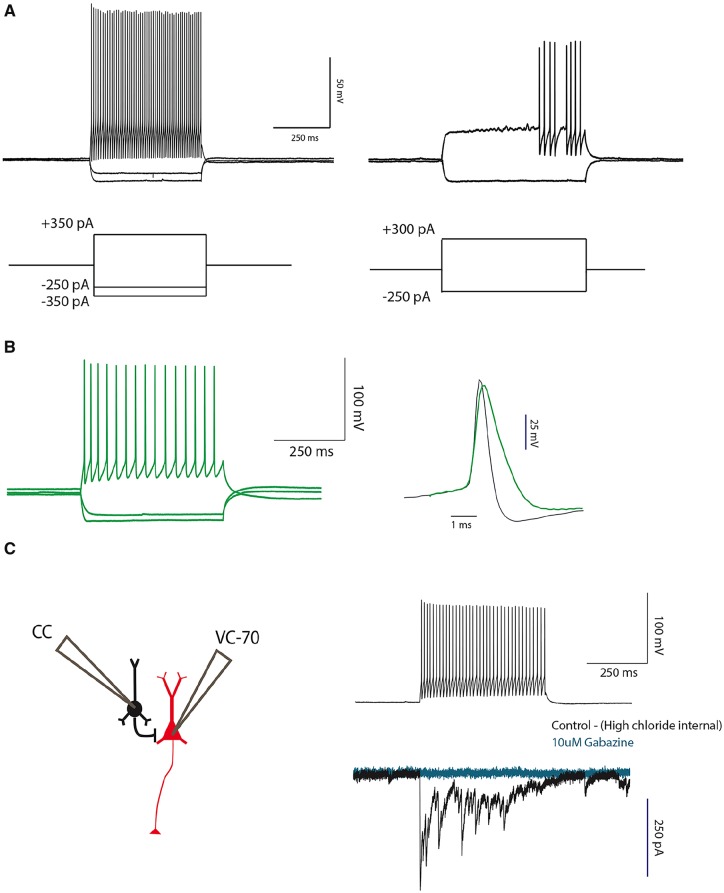

Transplanted MGE cells are GABAergic and presynaptic to cortical pyramidal cells. (A) Current-clamp recordings from GFP+ MGE neurons show fast spiking (left trace; n = 8/18) and latent fast spiking (right trace; n = 3/8). (B) Non-fast spiking MGE cells (left trace; n = 10/18) MGE cells. Right: The difference in action potential shape between a fast (blue) and a non-fast spiking (green) neuron. (C) Schematic (left) shows the paradigm used to establish functional connectivity between MGE (black) and host (red) pyramidal neurons. Panel to the right shows action potential discharges evoked in the MGE neuron (top) and the resulting IPSC in a host pyramidal neuron (bottom, black), which was blocked by 10 µM gabazine (blue; n = 3/17 of fast spiking neurons and 0/9 non-fast spiking neurons).